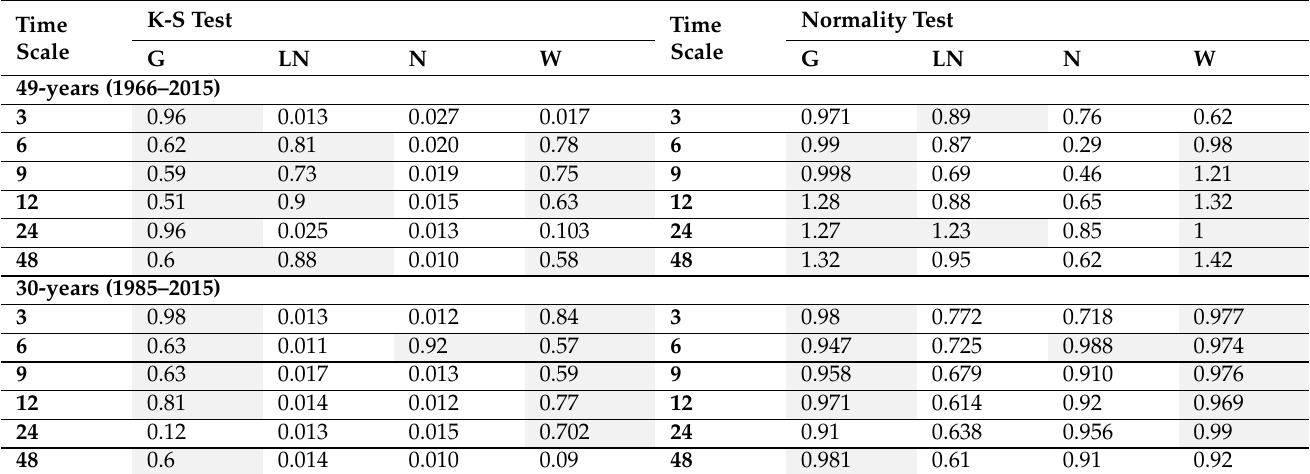
Table 2. Results of the Kolmogorov–Smirnov test (K-S test) at the 0.05 significance level and the Normality test.